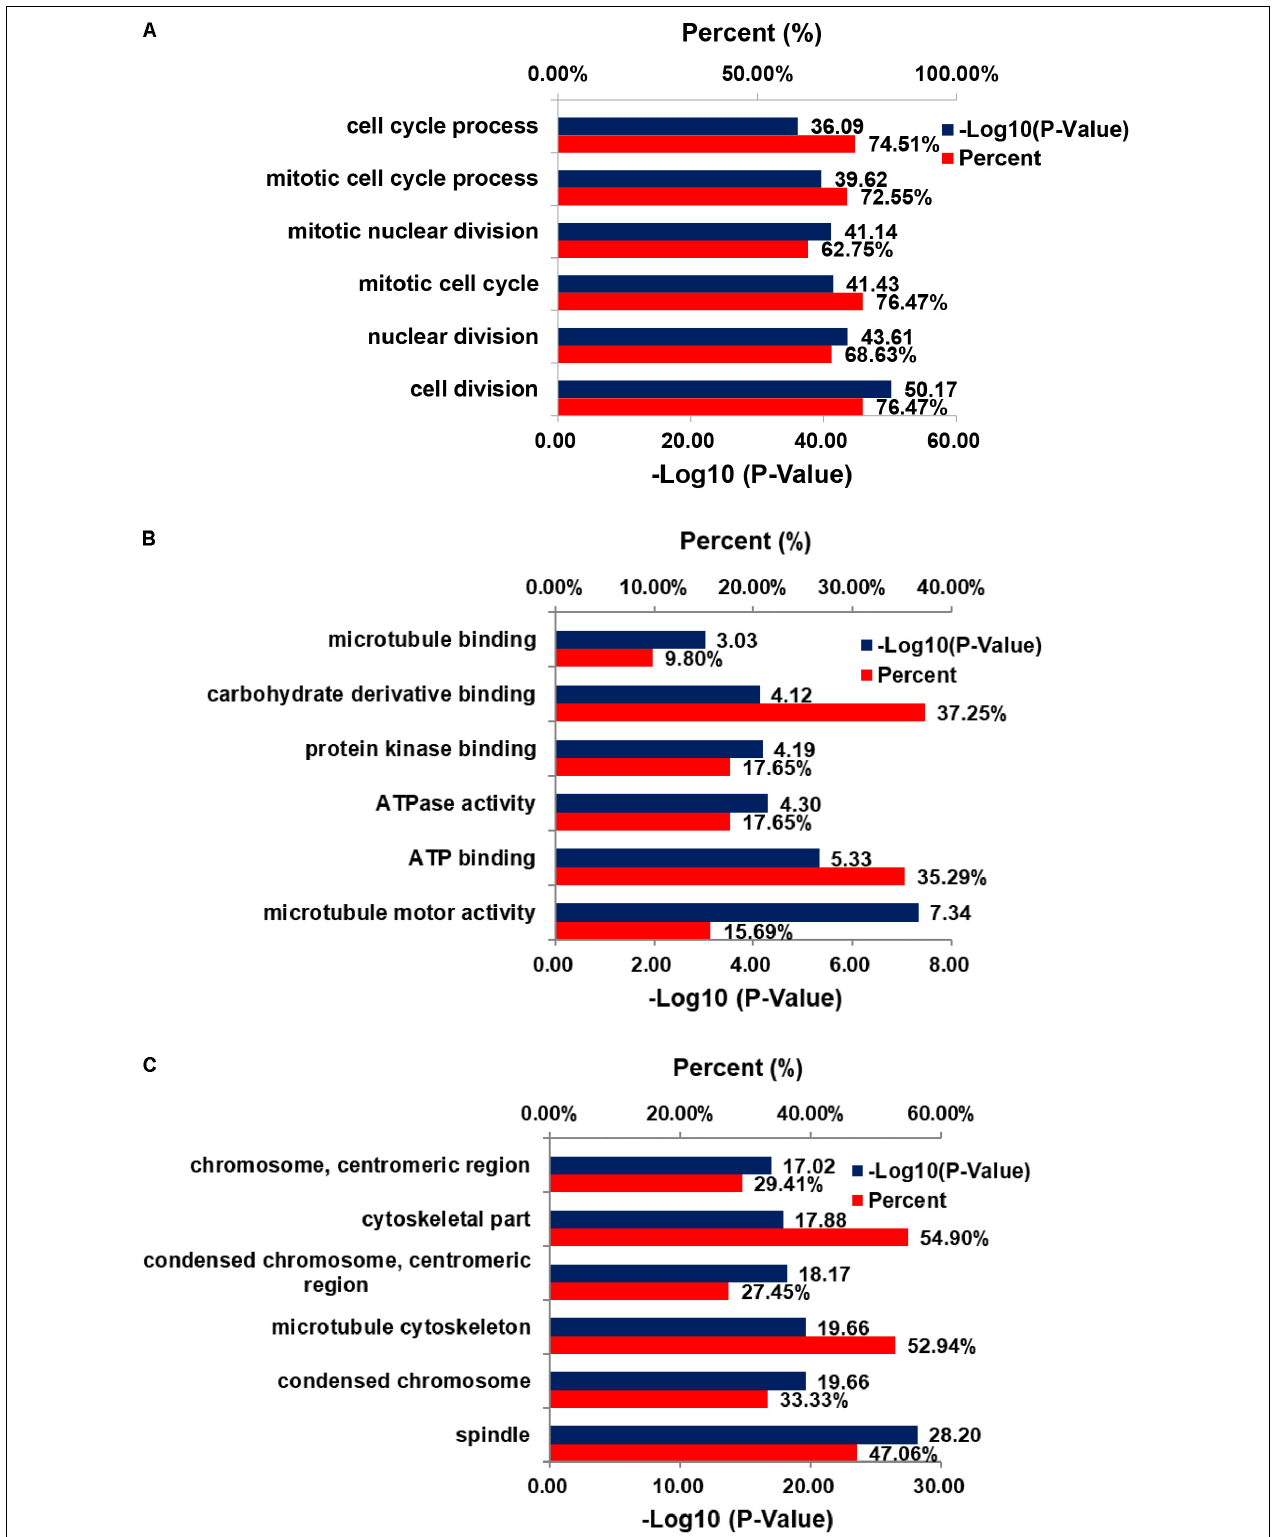
FIGURE 2 | GO enrichment of DEGs. (A) Cellular component; (B) biological process; (C) molecular function.